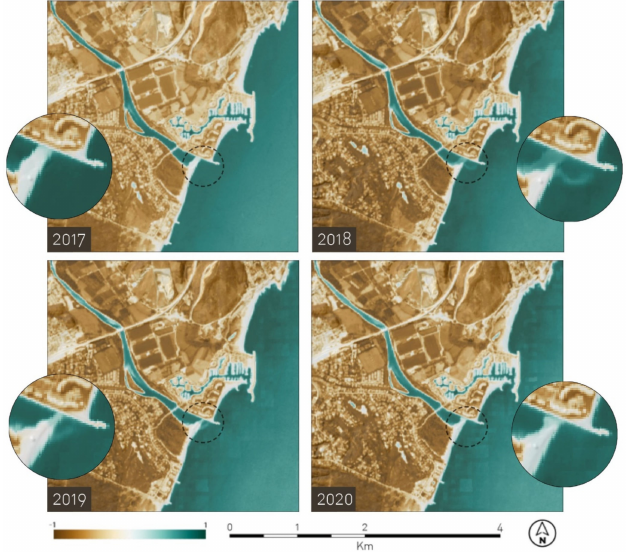
Figure 7. Annual climatologies using Sentinel-2 L2A images and NDWI index for the Guadiaro river mouth (single year means from 2017 to 2020). Scale